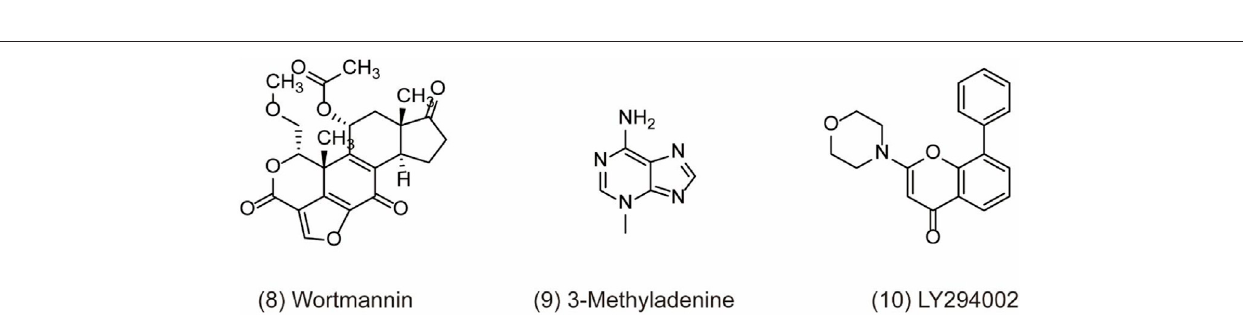
Frontiers in Pharmacology |